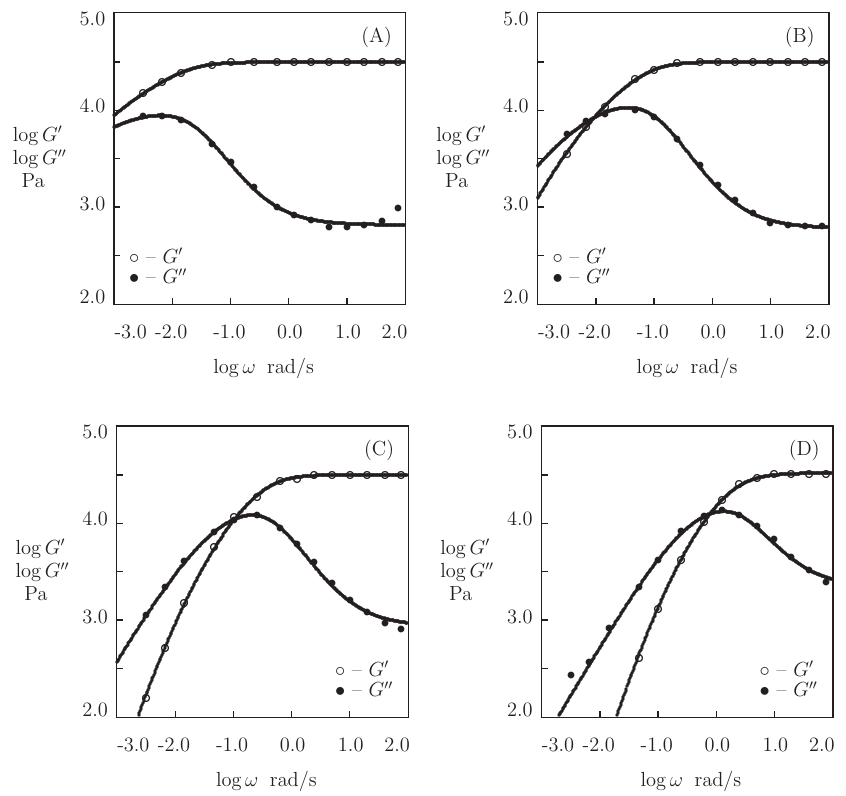
Figure 14. Storage modulus G (cid:48) and loss modulus G (cid:48)(cid:48) versus frequency ω . Symbols: experimen- tal data [73] on P 4 protein gel at various temperatures T (( A )– T = 5, ( B )– T = 20, ( C )– T = 35, ( D )– T = 50 ◦ C). Solid lines: the results of